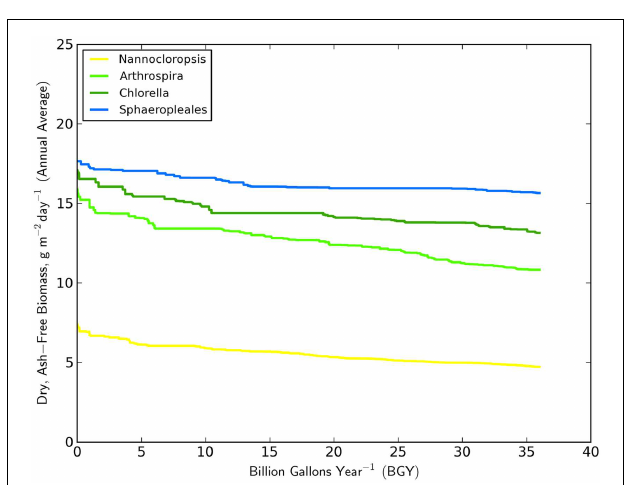
Table 3 | Summary of resource components used in the site prioritization and selection model .